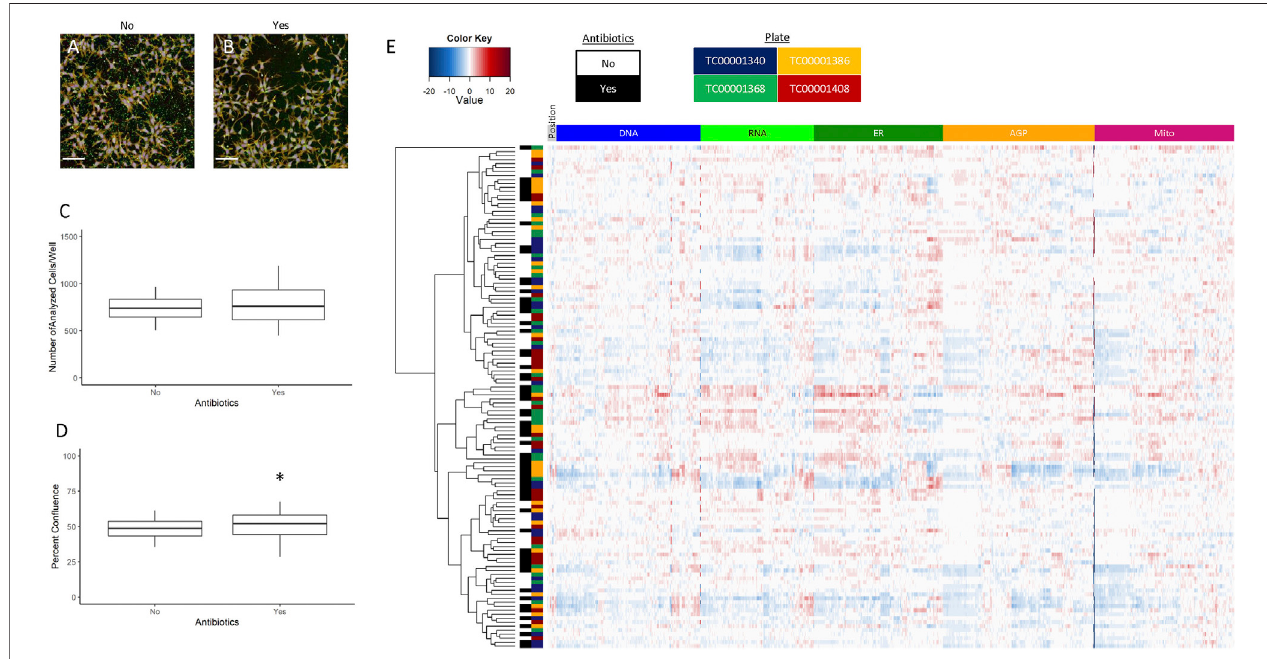
FIGURE 5 | ± Antibiotics. Images were captured with a 20X water immersion objective and Harmony ® software was used for further processing. A representative composite imagewithout (A) and with (B) antibiotics isdisplayed. Well-level data were exported to assess the number ofanalyzed cells/well (C) and percent con fl uence (D) , whereas cell-level data were exported for the heatmap (E) . The graphs and heatmap represent four biological replicates (i.e., independent cultures) which includes 16 technical replicates/condition per biological replicate. The rows and columns on the heatmap depict individual wells and features, respectively, and is further labelled by antibiotics (no or yes) and by plate (TC0000####). Heatmap coloring represents the size and direction of the phenotypic effect relative to the no antibiotic condition. All statistical comparisons were made to “ without antibiotics ” (adjusted p -value, * p < 0.05). Scale bar = 100